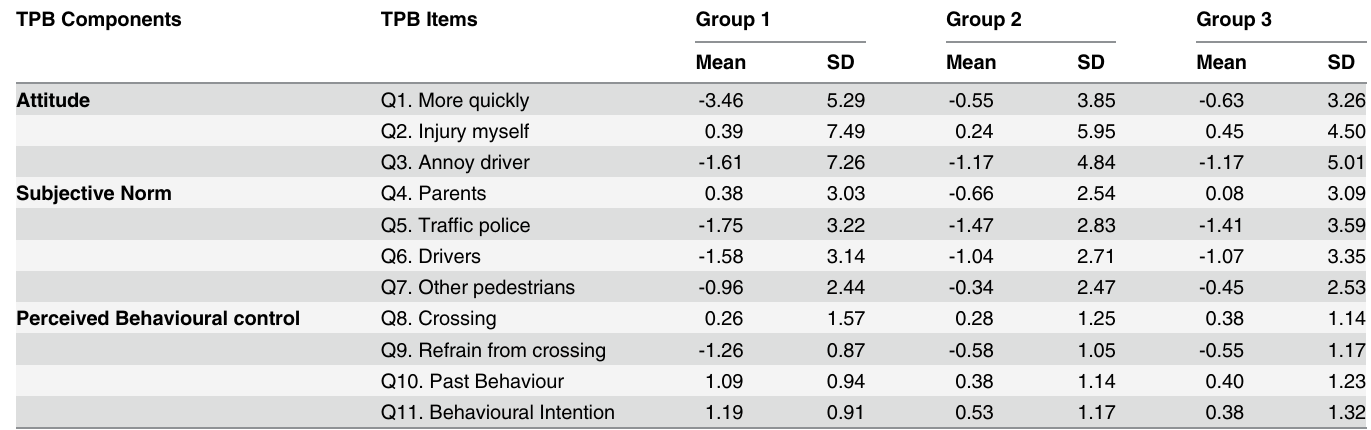
Table 2. Means and SD of items of the TPB. TPB Components